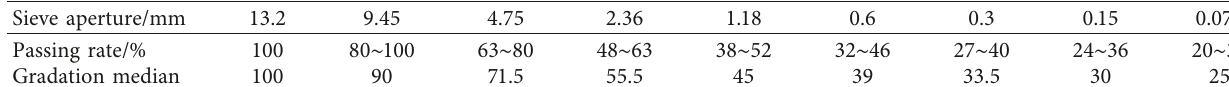
Table 4: CGA-10 matching requirements.